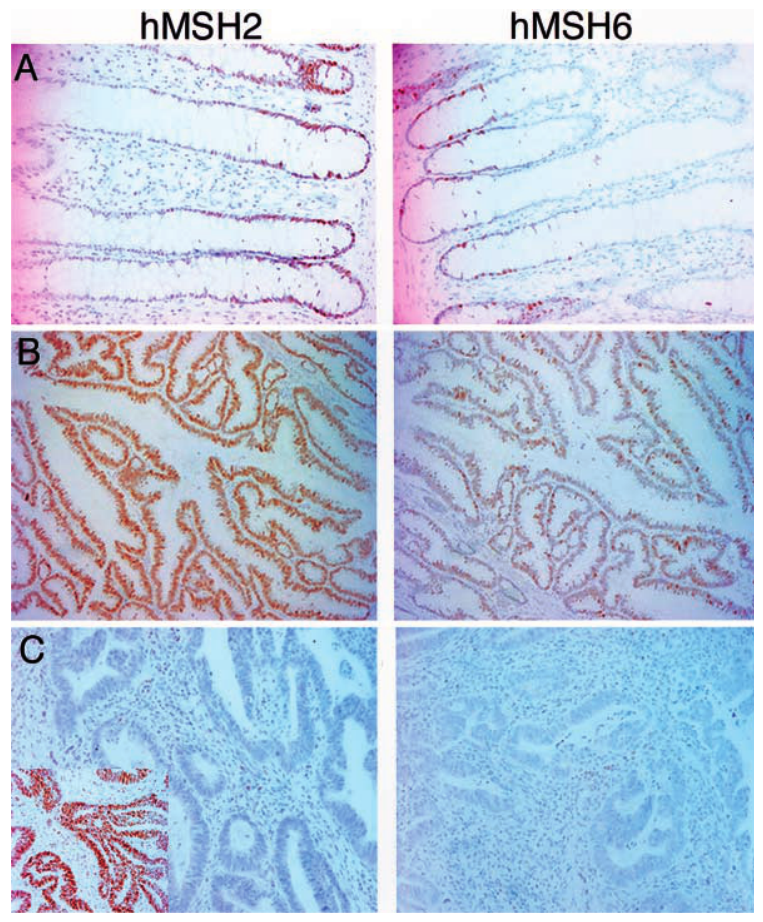
Imunohistochemical expression patterns of hMSH2 and hMSH6 in colorectal mucosa and tumours. A) normal mucosa: MMR proteins are expressed in the proliferative compartment of the colorectal crypts (lower 2 / 3 ) where most of the nuclei are positive for hMSH2, whereas hMSH6 expression is confined to only some of the cells of this compartment. B) adenomatous region of a colon cancer: also in these lesions, the pattern of expres- sion of hMSH6 is “interspersed”, whereas hMSH2 is expressed in most of the tumour cells. C) MMR-deficient colon carcinoma: this tumour was excised from a member of a HNPCC family carrying a germ-line mutation in hMSH2 . Usually, a second alteration occurs in the wild-type allele of hMSH2 in the tumour and hMSH2 is not expressed at all. Consequently, hMSH6 is degraded (see Introduction) and the same tumour is also negative for this latter protein. Some non-neoplastic cells in the lamina propria are positive for hMSH2 and hMSH6 as expected, and the other MMR proteins are normally expressed in this tumour as shown for hMLH1 in the superimposed image in C.